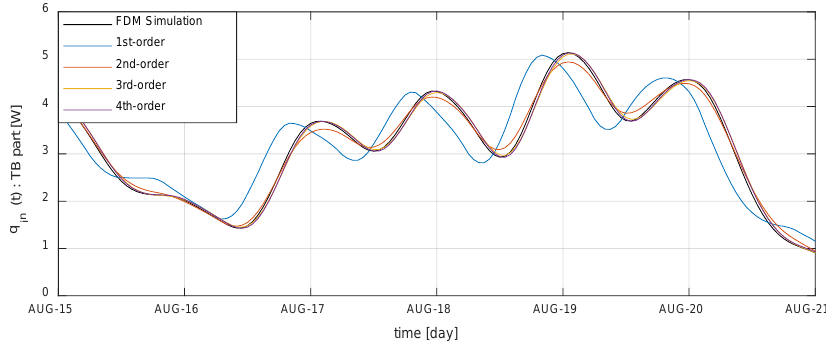
Figure 11. System response for the annual outdoor temperature (Summer).